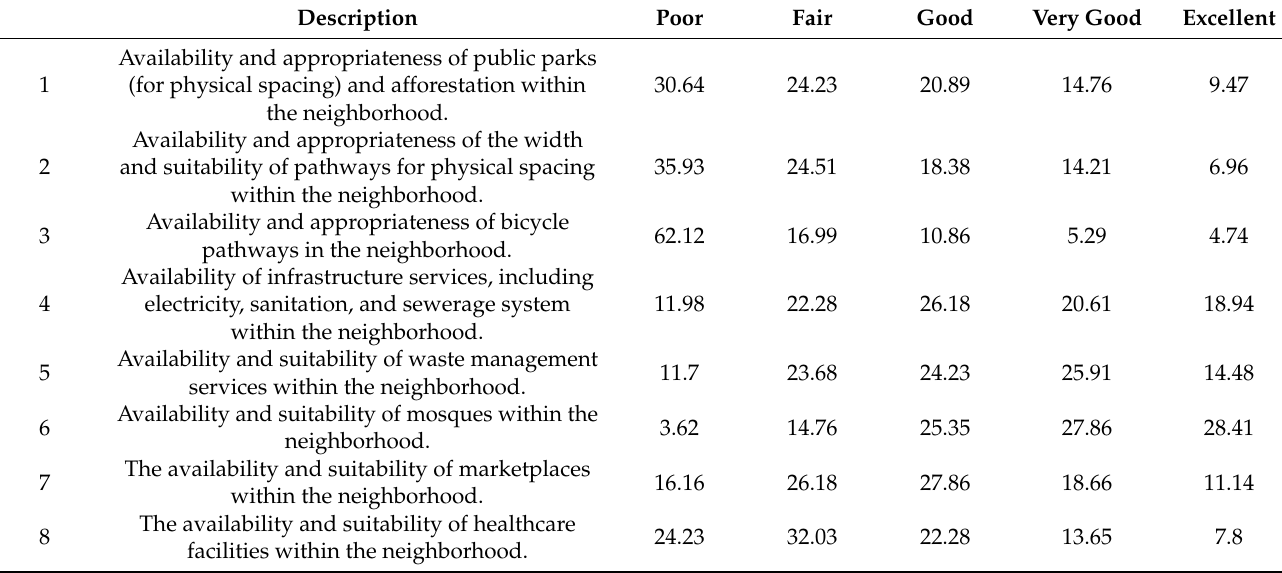
Figure 3. Types of neighborhoods. Table 2. Evaluation of the urban planning of the residential